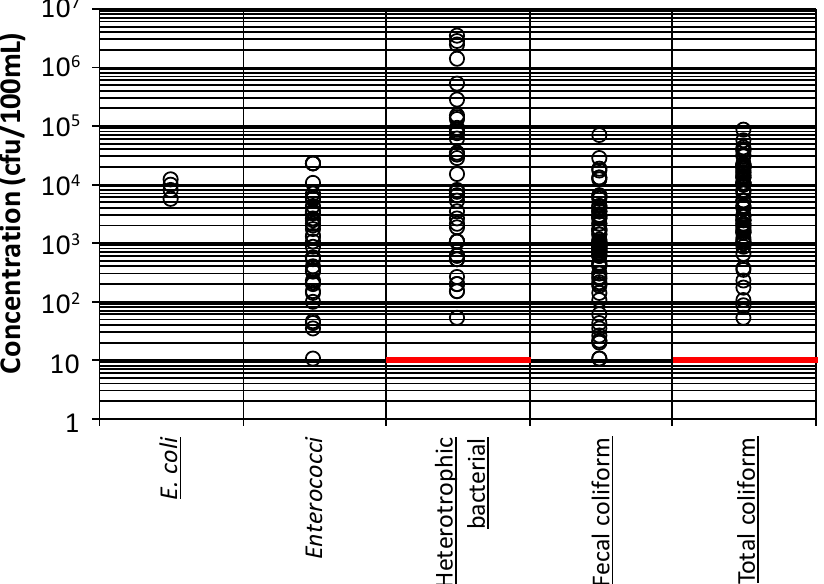
Figure 5. Observed concentrations of microorganisms (circles) in surface water in the reviewed studies referring to South Africa and the corresponding limits set by SANS-241 (red dashes) for drinking water. In the X axis, the underlined names refer to indicator bacteria, those not underlined refer to pathogen bacteria. Data from: [ 2,3,28,37,44,51,56].